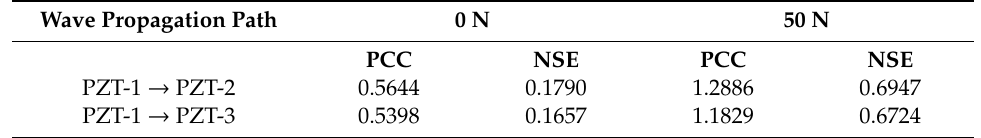
Table 3. Damage indices of PCC and NSE for signals obtained from d15 PZT-2 and d31 PZT-3 at 0 N (no-preload condition) and at 50 N preload applied on the specimen at 1.3 mm three-point loading